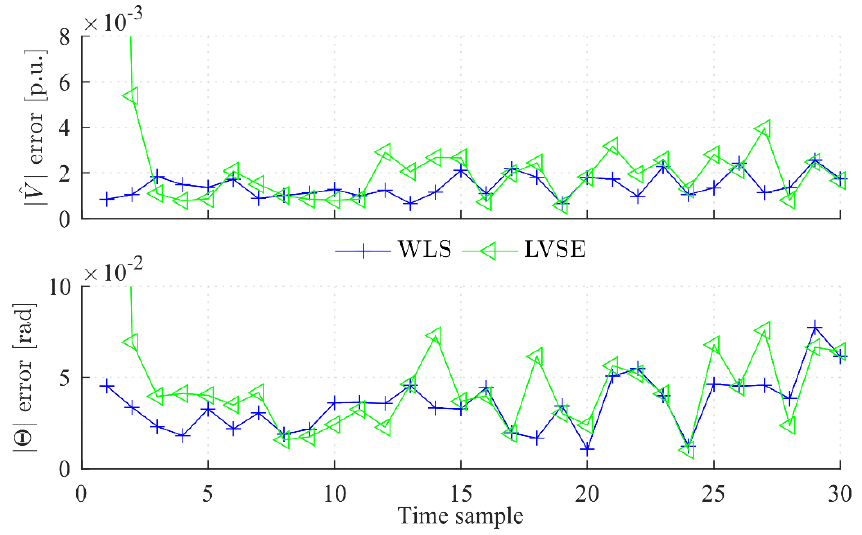
Figure 4. Estimation error — case 2.